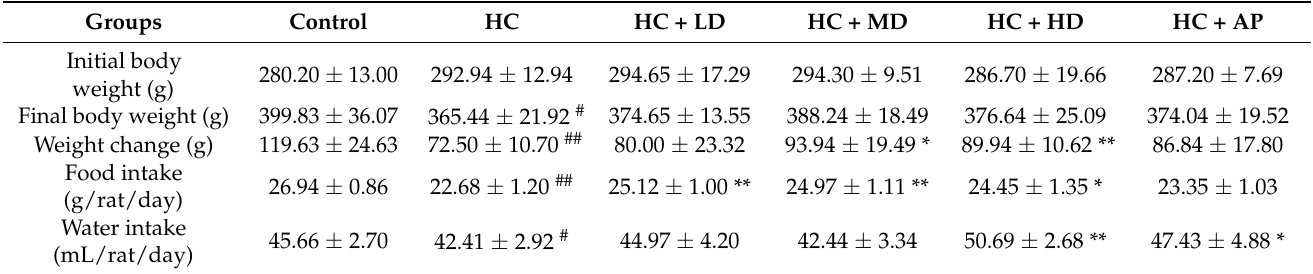
Table 1. Effects of TCI227 on the initial body weight, final body weight, weight change, food intake, and water intake of potassium-oxonate (PO)-induced hyperuricemia SD